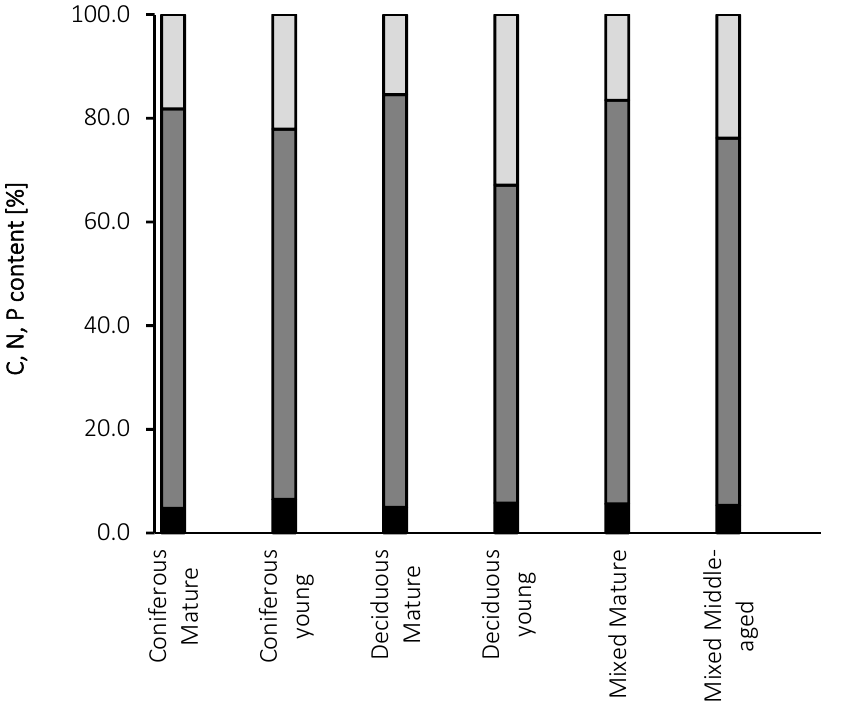
Figure 10. Contribution of C org , N tot , and P content in the analyzed forest soils.